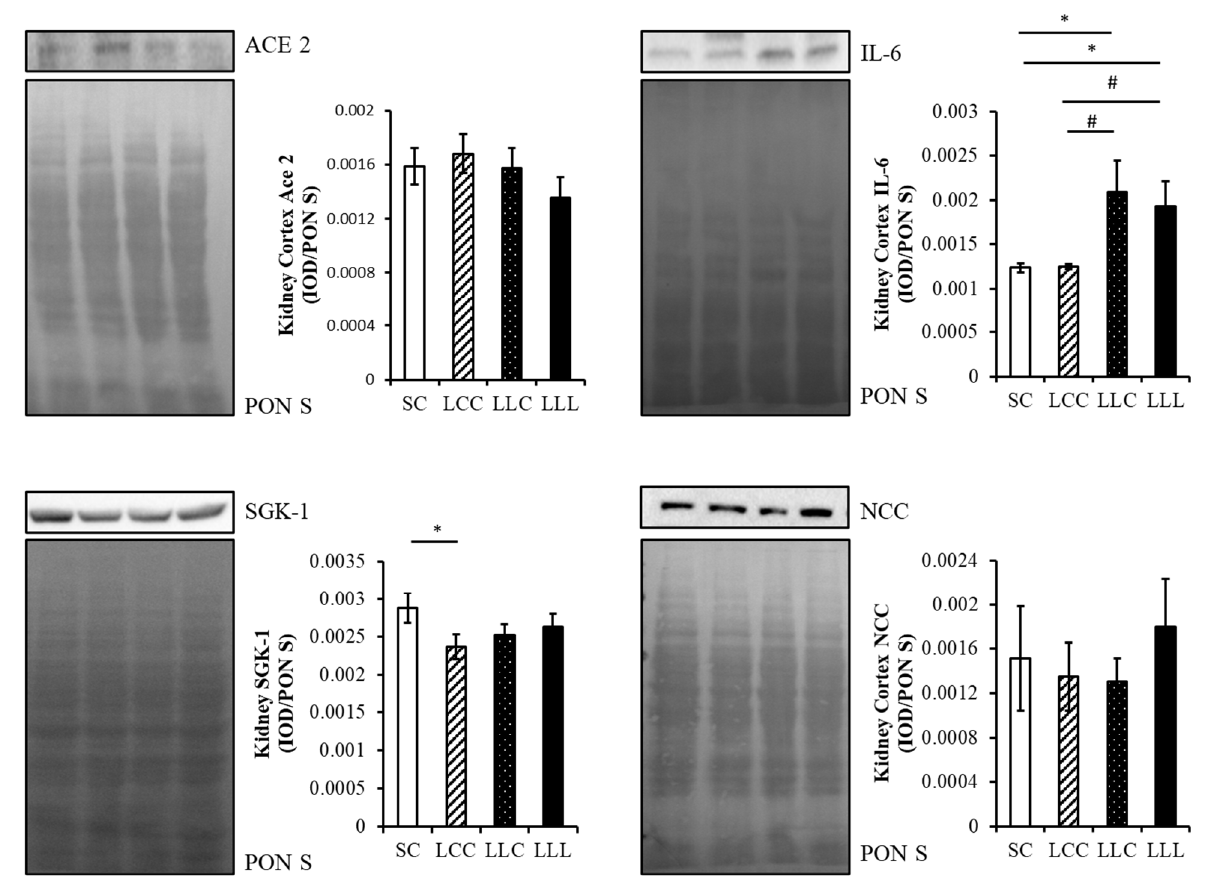
Figure 5. Offspring renal cortex ACE2, IL-6, SGK1, and NCC abundance. Four groups were evaluated by one-way ANOVA with the LSD post hoc test. * vs. SC, p < 0.05; # vs. LCC, p < 0.05.